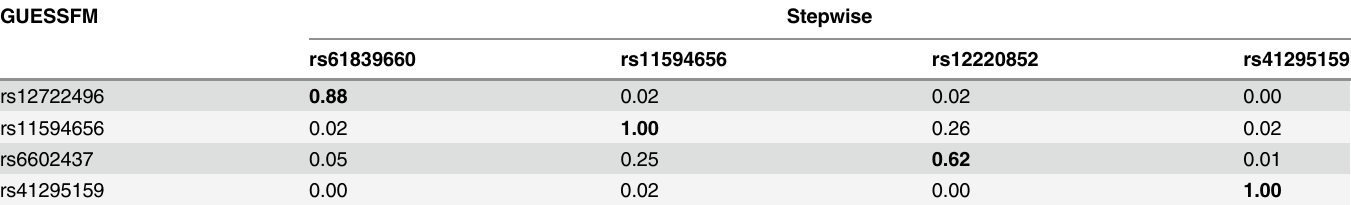
Table 2. LD ( r 2 ) between SNPs in selected models for T1D using stochastic GUESSFM and stepwise searches. Each GUESSFM search signal has a correspondng SNP found by conditional stepwise regression in moderate to strong LD.